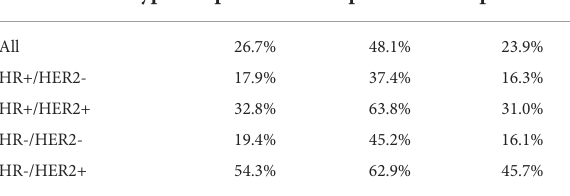
TABLE 2 Breast, axillary lymph node and total pCR rates for different molecular subtypes. Molecular subtype